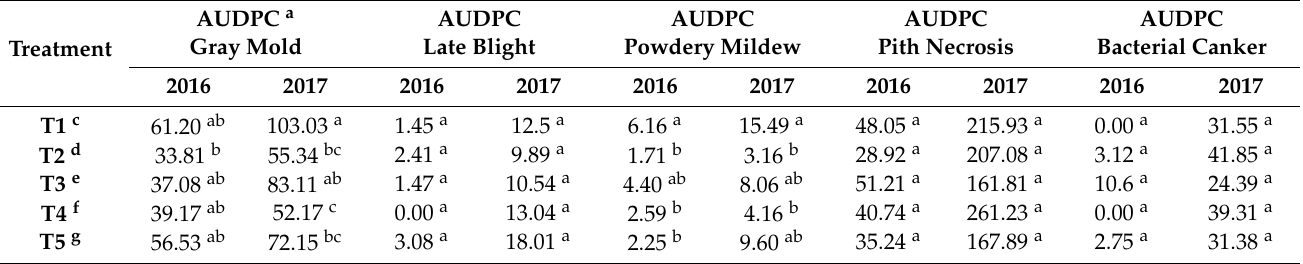
Table 2. Effect of combined use of Bacillus subtilis applied to the drip irrigation and foliar sprays of biorational products for controlling tomato diseases under greenhouse conditions in 2016 and